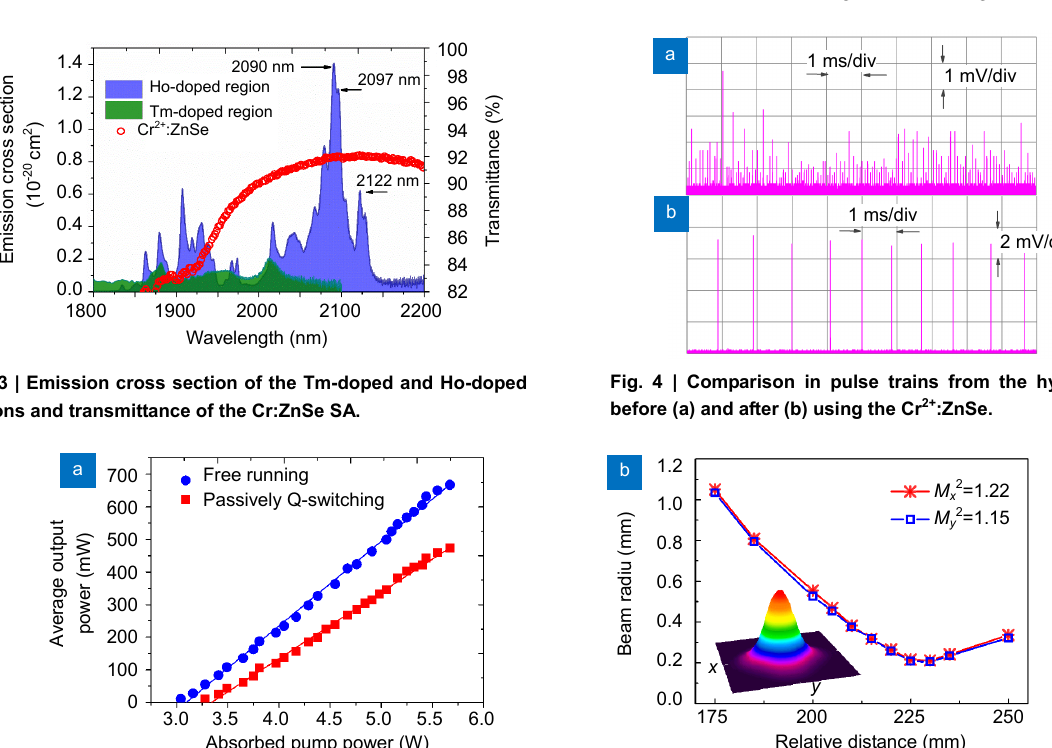
Fig. 5 | ( a ) Average output powers of the free-running Ho laser and PQS Ho laser versus absorbed pump power. ( b ) Beam profile of the PQS composite Ho laser at the maximum output power of 474 mW (Inset: 3D beam profile at the beam